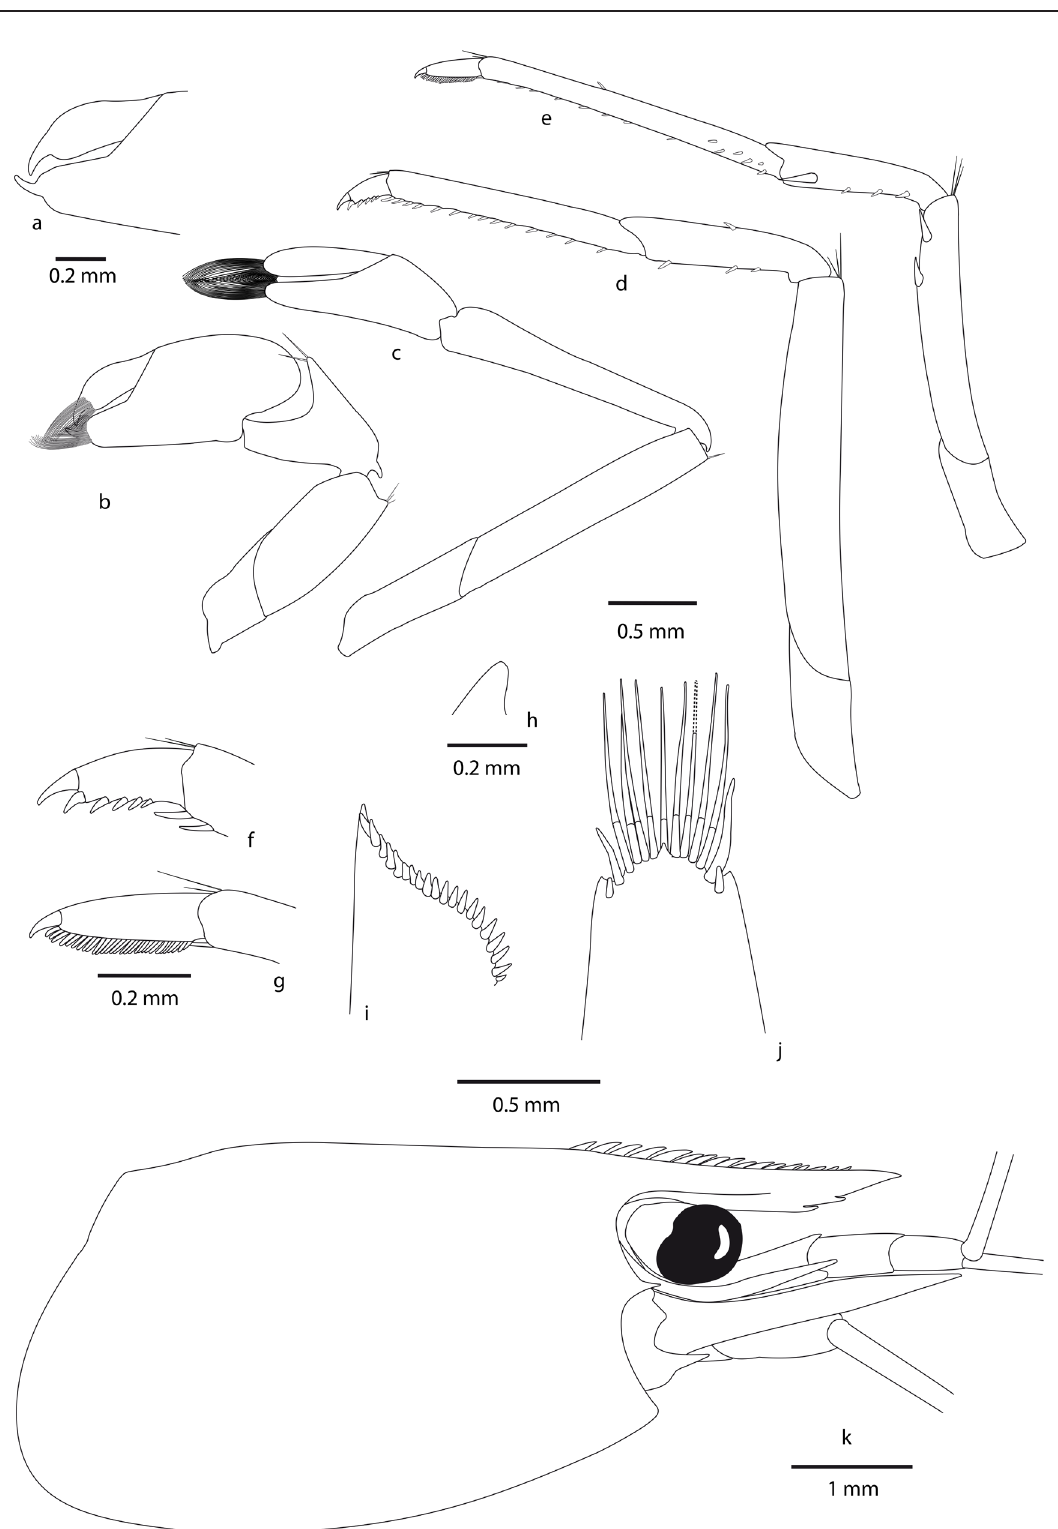
Fig. 13. Caridina gueryi Marquet, Keith & Kalfatak, 2009. a . Details of the fingers of the first pereiopod. b . First pereiopod. c . Second pereiopod. d . Third pereiopod. e . Fifth pereiopod. f . Dactylus of third pereiopod. g . Dactylus of fifth pereiopod. h . Pre-anal carina. i . Uropodal diaeresis. j . Telson. k . Cephalothorax. MNHN-IU-2015-19